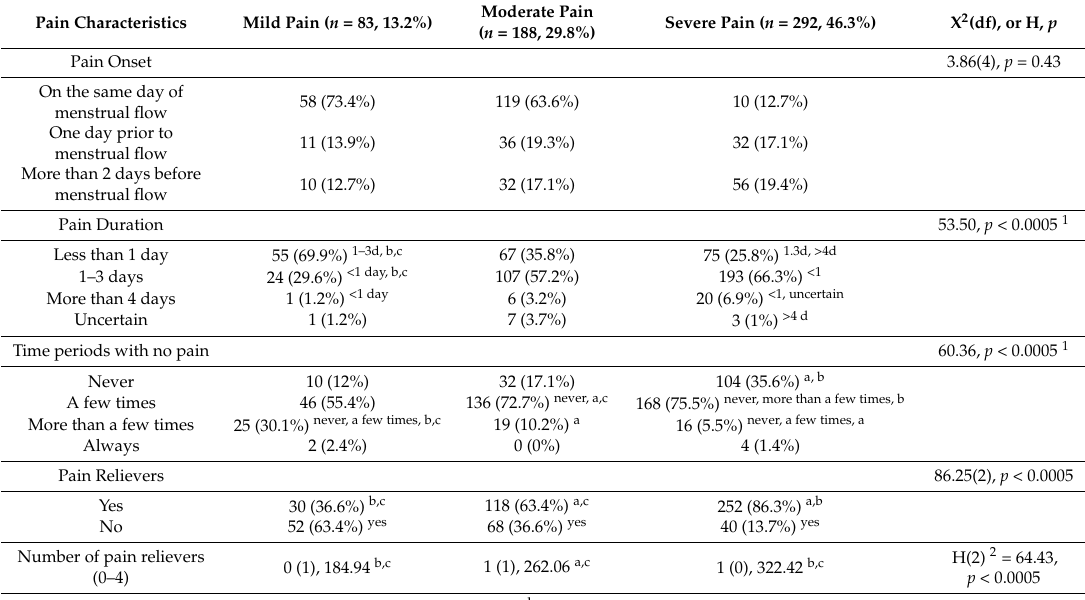
Table 4. Dysmenorrhea intensity and pain